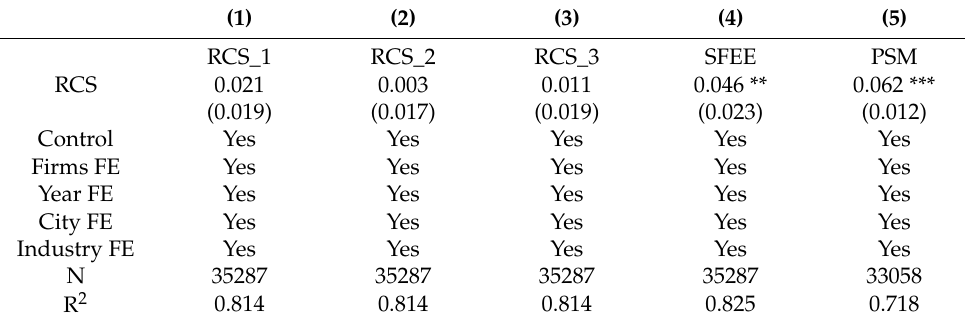
Table 5. Robustness